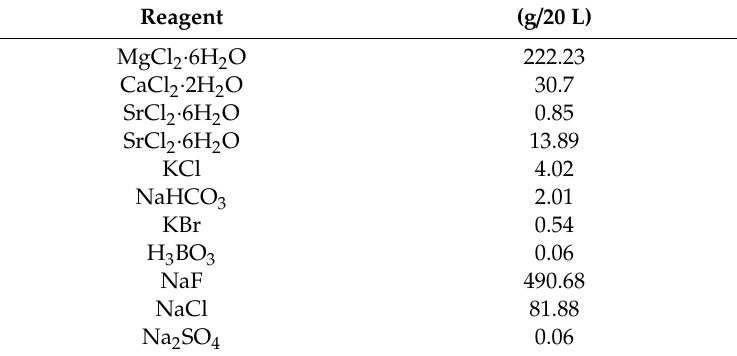
Table 1. Composition of artificial seawater (Aquamarine,